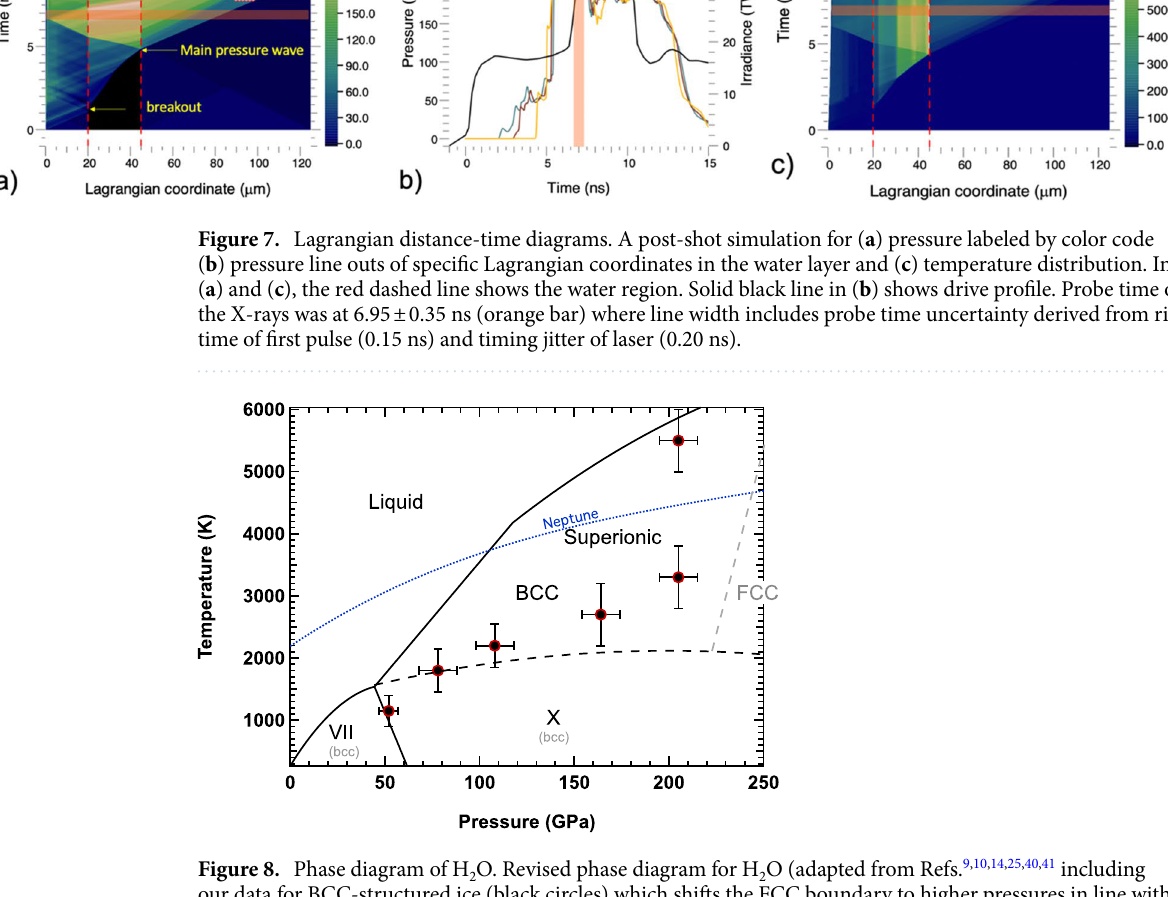
Figure 8. Phase diagram of H 2 O. Revised phase diagram for H 2 O (adapted from Refs. 9,10,14,25,40,41 including our data for BCC-structured ice (black circles) which shifts the FCC boundary to higher pressures in line with theoretical predictions from Refs. 10,25 ). Blue dashed line is the Neptunian isentrope 36